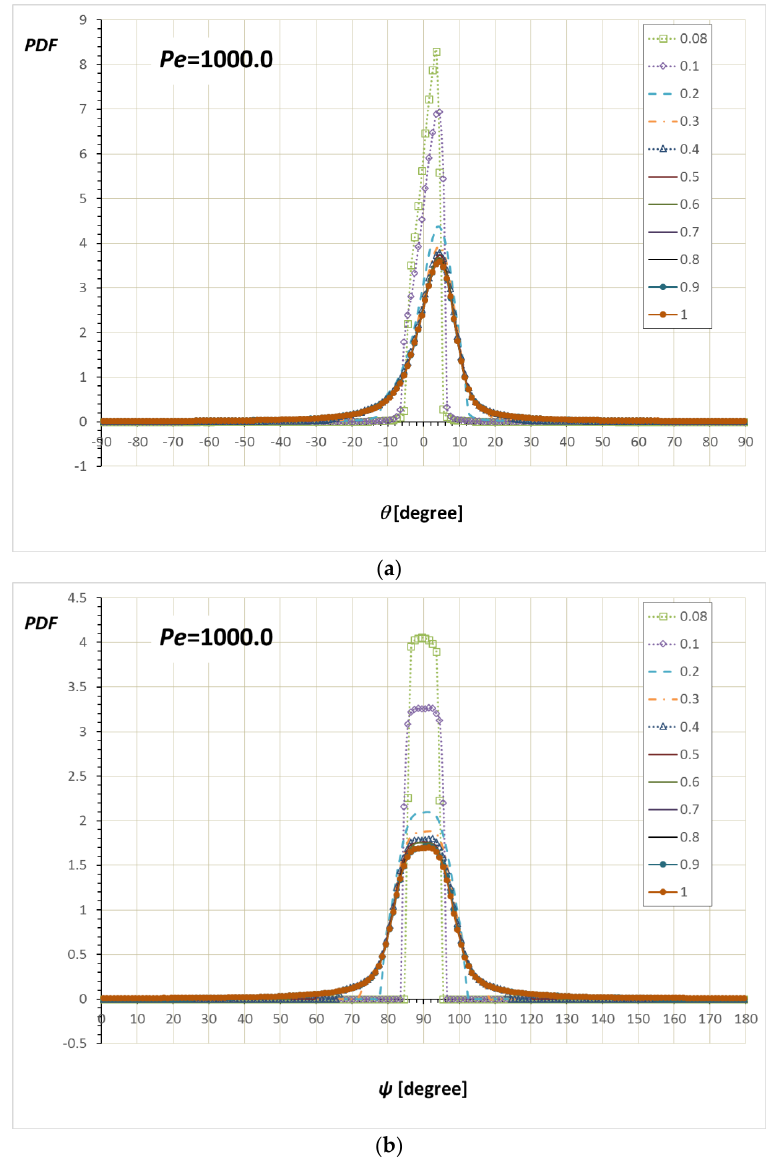
Figure 12. Simulation results for the ( a ) PDF( θ ) and ( b ) PDF( ψ )/sin ψ at Pe = 1000 with various α / a . It is seen that θ max ≈ 4.5°, which corresponds to α = 0.078 a .